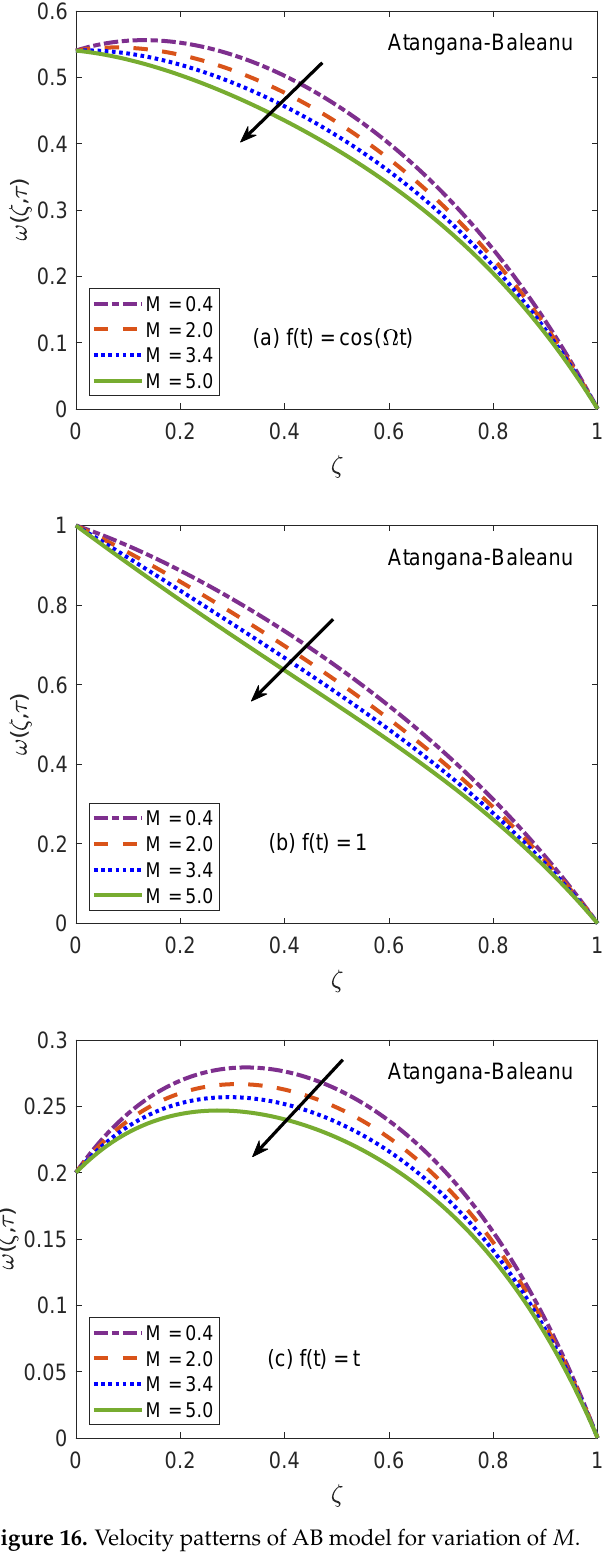
Figure 16. Velocity patterns of AB model for variation of M